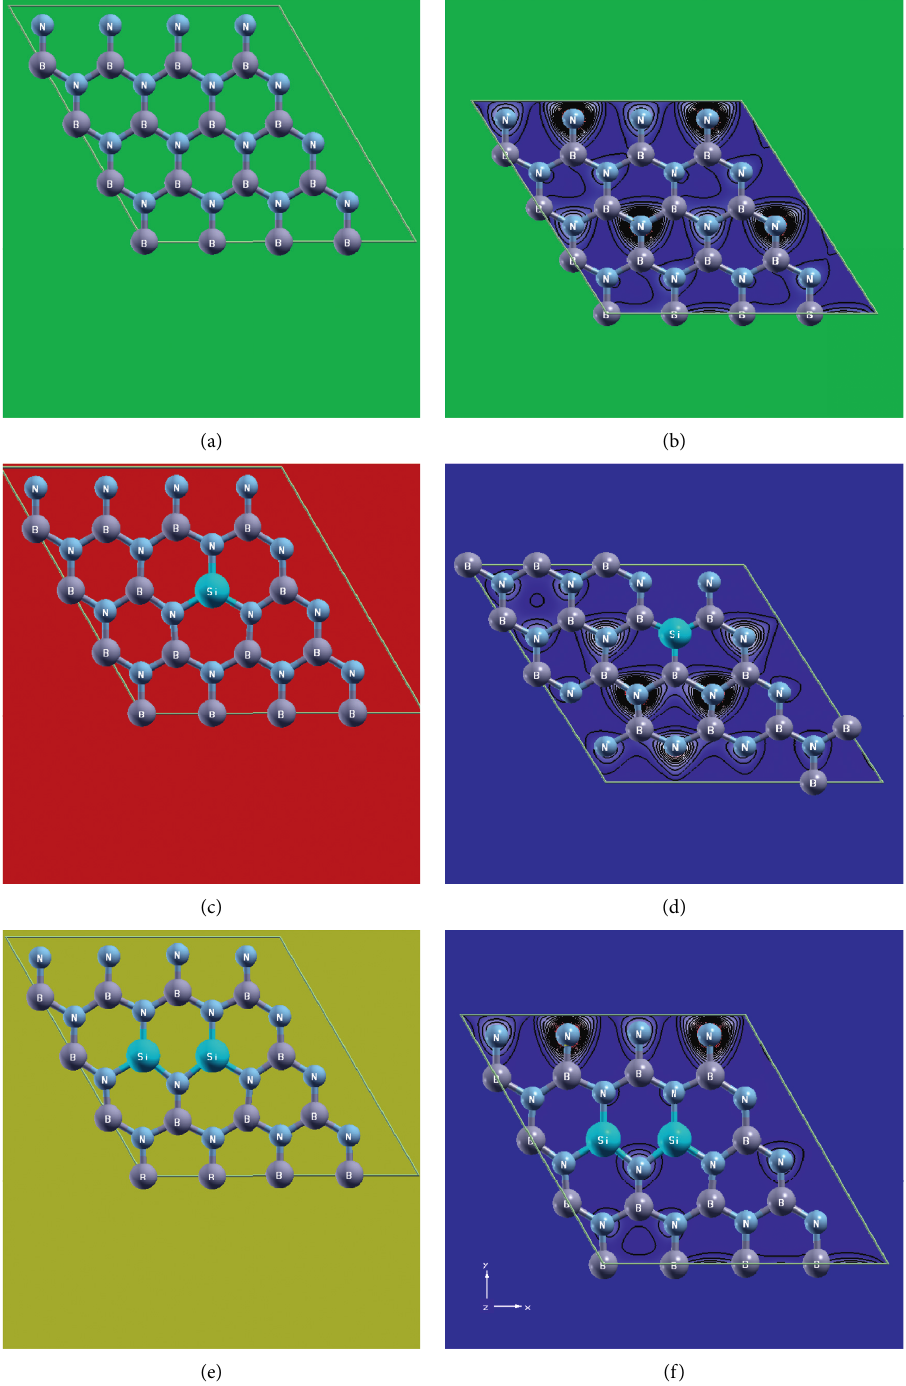
Figure 1: Optimized geometry of a 4 × 4 × 1 BN supercell doped with single and two Si atoms and its isosurface plot of charge density.